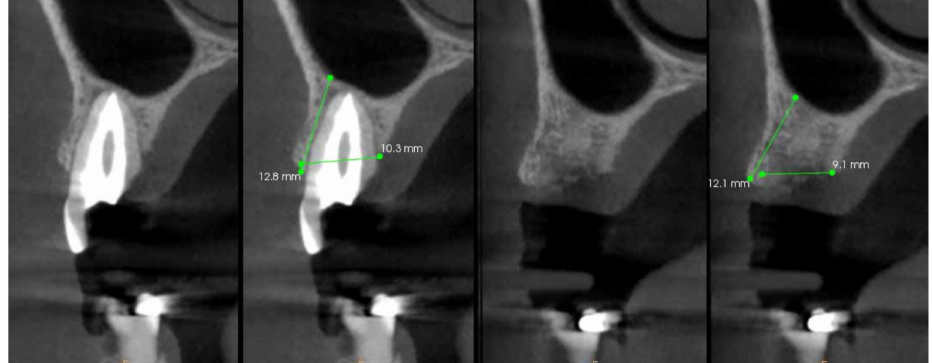
Figure 4. Measurements performed on the CBCT0 and CBCT1: alveolar bone width (ABW) and alveolar bone height